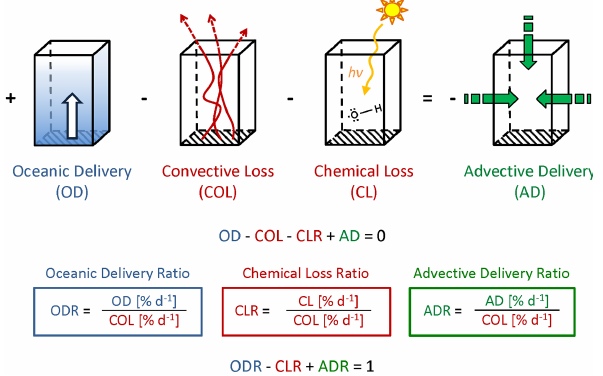
Figure 2. Schematic summary of the components of the applied mass-balance concept from Fuhlbrügge et al. (2016): oceanic deliv- ery (OD), the convective loss (COL), the chemical loss (CL), the ad- vective delivery (AD), the oceanic delivery ratio (ODR), the chem- ical loss ratio (CLR) and the advective delivery ratio (ADR). The shaded area reflects an area of 400m 2 .